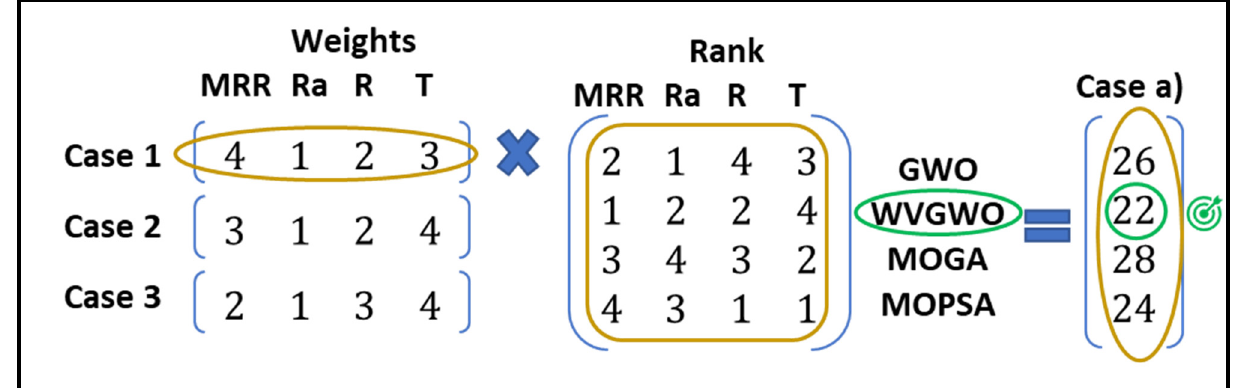
Figure 15. Suggested minimum goal scoring method.